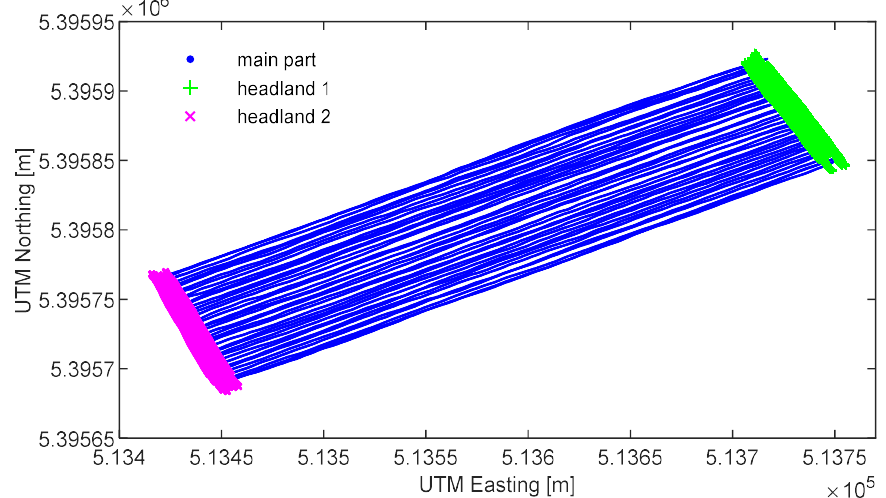
Figure 12. Field part distinction showing the D-GNSS positions of the in-work points of the main part